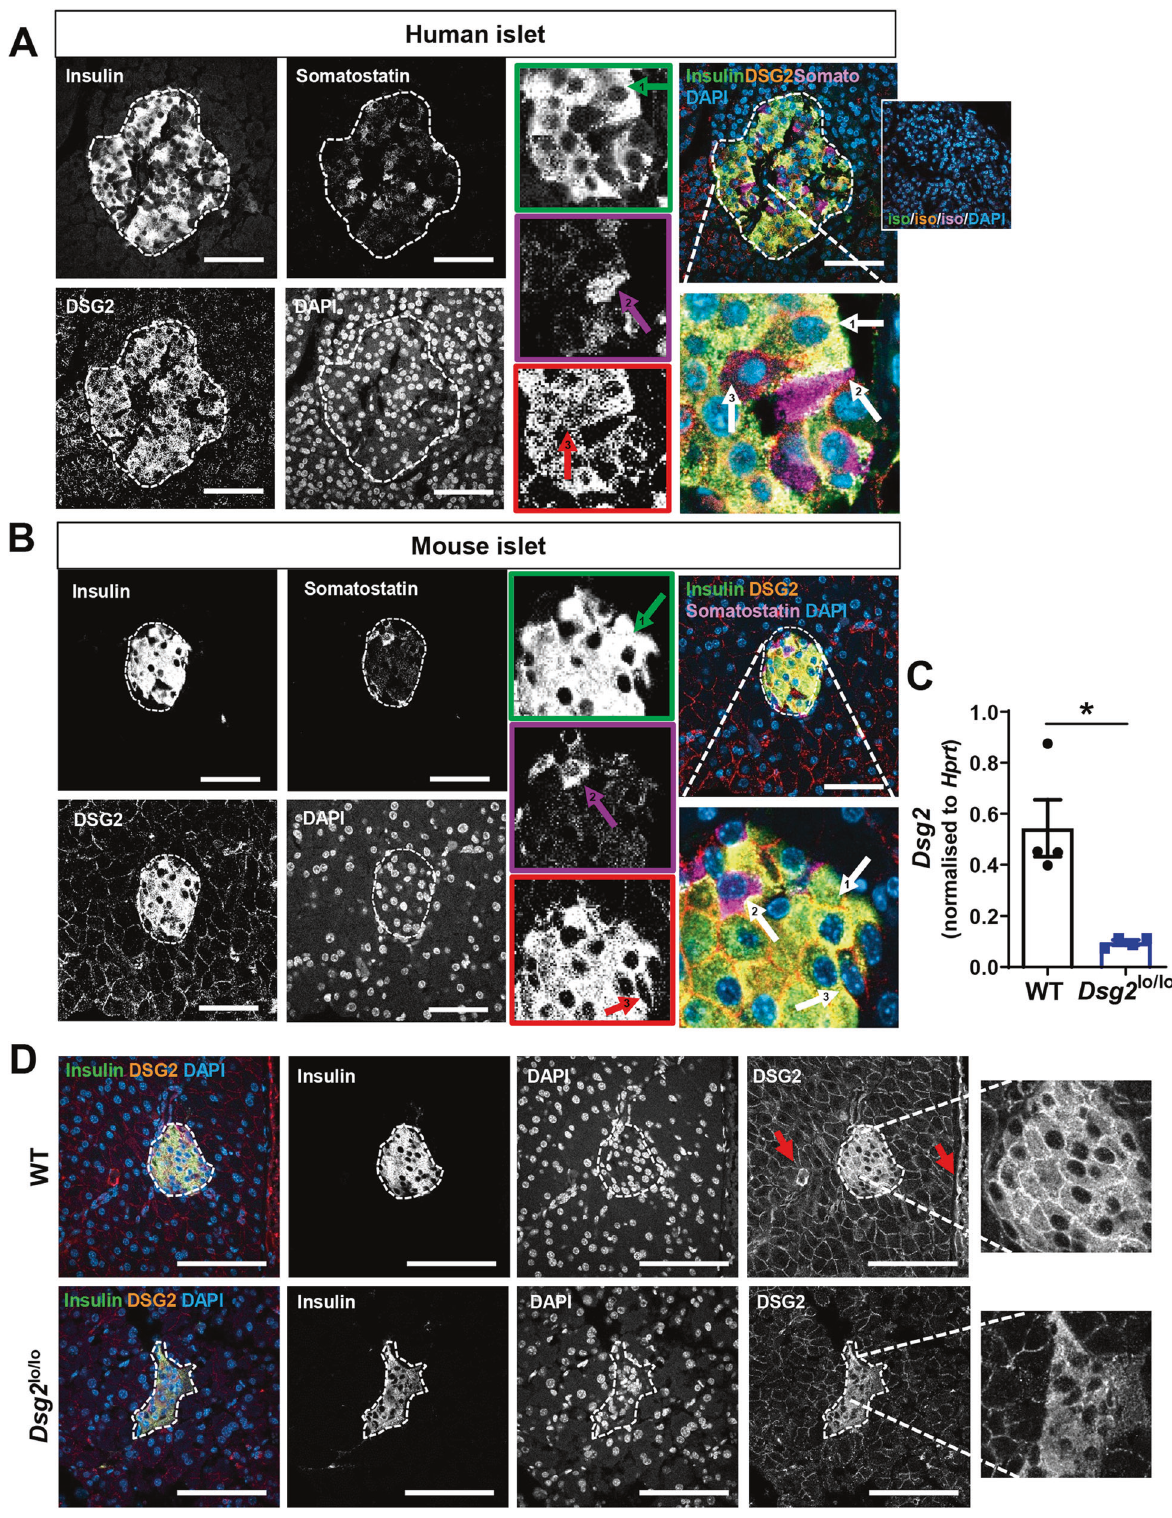
Fig. 2 DSG2 expression by select cell types in the islets of humans and mice. Immuno fl uorescence confocal microscopy of A human and B mouse islets stained for insulin (green), DSG2 (red), somatostatin (magenta), and nuclei (DAPI, blue). Insets with arrow labelled ‘ 1 ’ indicating insulin-positive cells, arrow labelled ‘ 2 ’ indicating somatostatin positive cells, and cells with neither insulin nor somatostatin staining indicated with arrow labelled ‘ 3 ’ . Scale bar = 50 μ m. Insert top right is representative of isotype control stains. C Mouse pancreata were isolated from wildtype (WT, black circles) and Dsg2 lo/lo (blue squares) mice and Dsg2 gene expression determined via qRT-PCR. Data are expressed as mean ± SEM relative to housekeeper gene ( Hprt1 ), n = 4 mice per group, * p < 0.05 vs WT. D Immuno fl uorescence confocal microscopy of pancreas sections from WT and Dsg2 lo/lo mice stained for insulin (green), DSG2 (red), and nuclei (blue). Red arrow indicating blood vessels. Scale bar = 50 μ m.